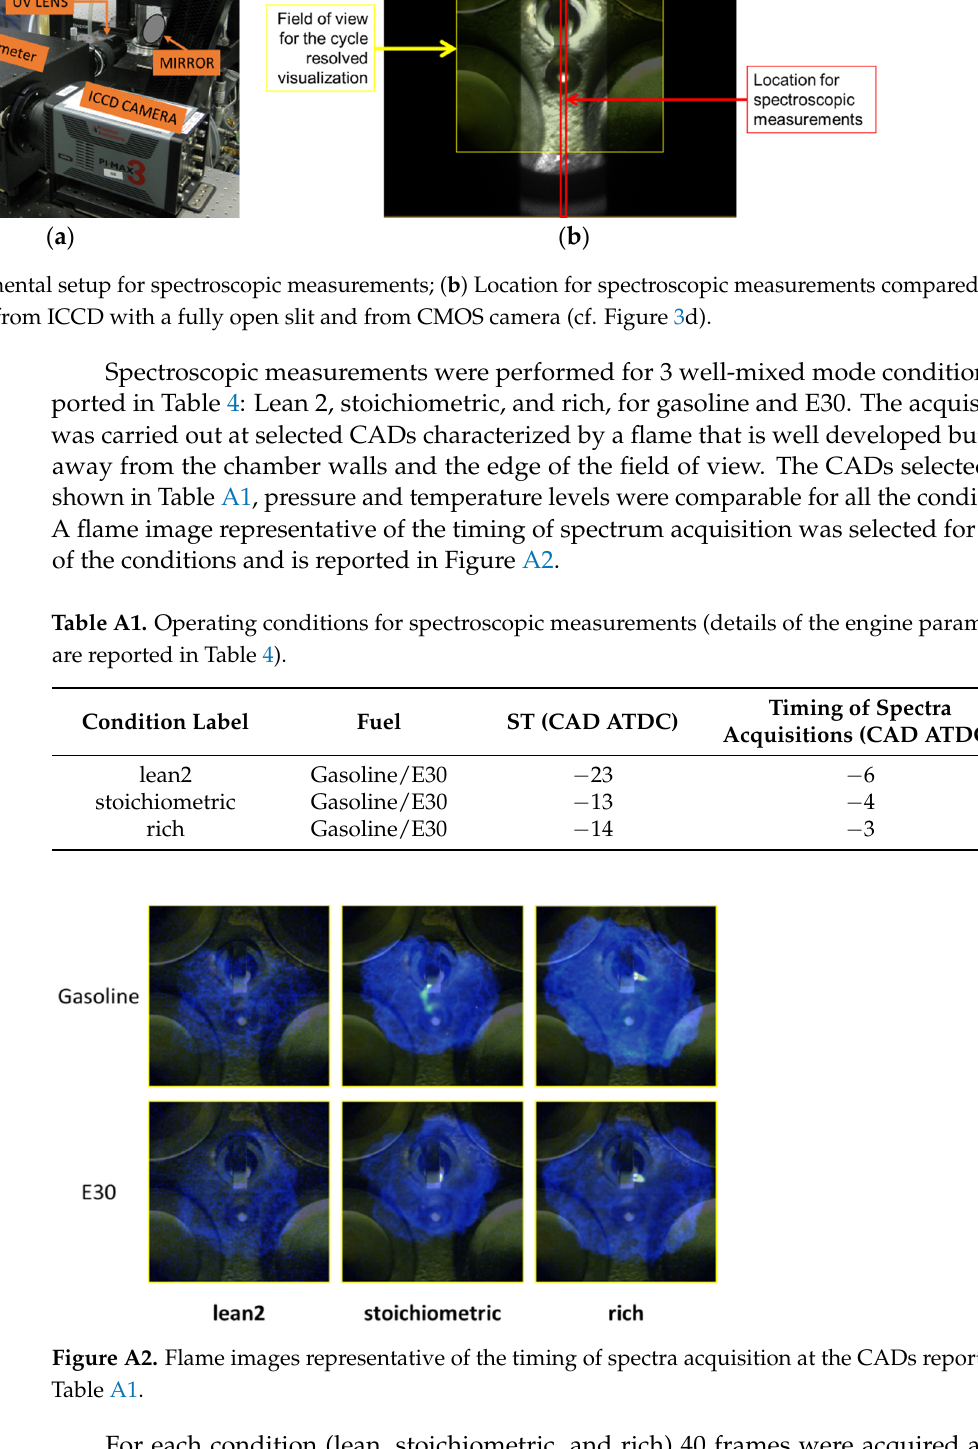
( b ) Figure A3. UV-VIS flame emission spectra detected at the selected CAD for: ( a ) Gasoline; ( b ) E30. For both fuels and each φ , spectra were featured by OH* indicating an occurring ox- idation. In reaction mechanism models of gasoline and ethanol the OH radical is involved in the initial decomposition of the fuel molecule, it is produced during oxidation as a product of chain branching and propagating reactions and is a reactant in exothermic chain propagating reactions [28]. Since the work of Dieke and Crosswhite [29] the OH* flame emission spectrum is known and well-investigated, it is mainly composed by band systems at 309 nm (highest), between 280–296 nm and between 314–325 nm, all due to (A–X) transition. In the spectra reported here, the peak corresponding to 309 nm is extremely evident and it can be noted that its absolute height is highest for stoichiometric conditions. A lower intensity band between 280 and 296 nm can also be detected.